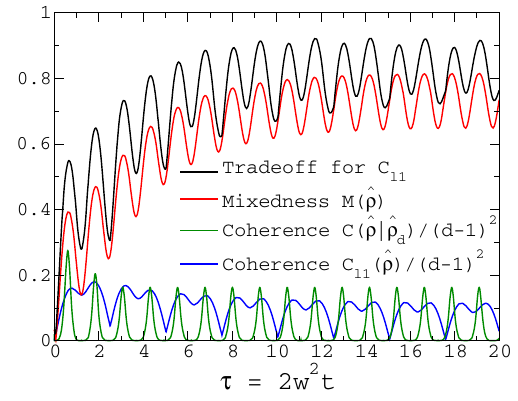
Fig. 10 Thetimedependence ofcoherence,mixednessandtheirtrade- off when β = π/ 6, ¯ ω B = μ ν B /w 2 = 10 and μ ν B /ω ν =